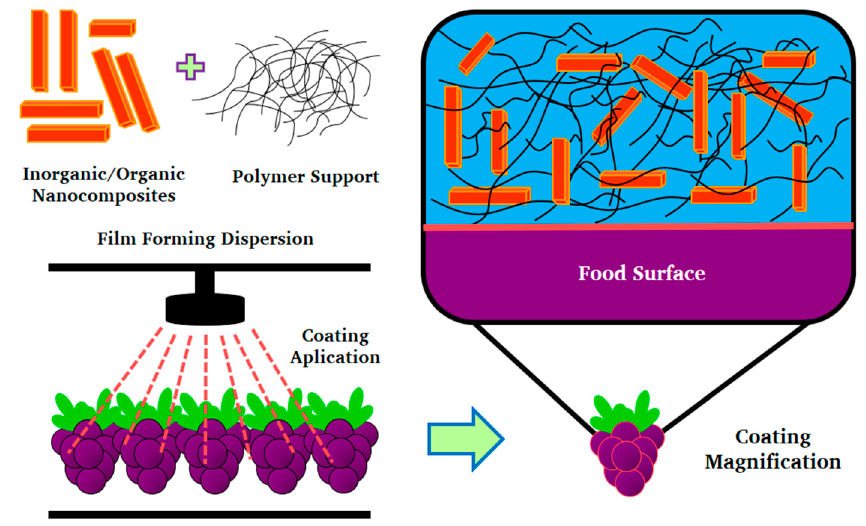
Figure 4. Inorganic nanocomposites incorporated in edible coating.